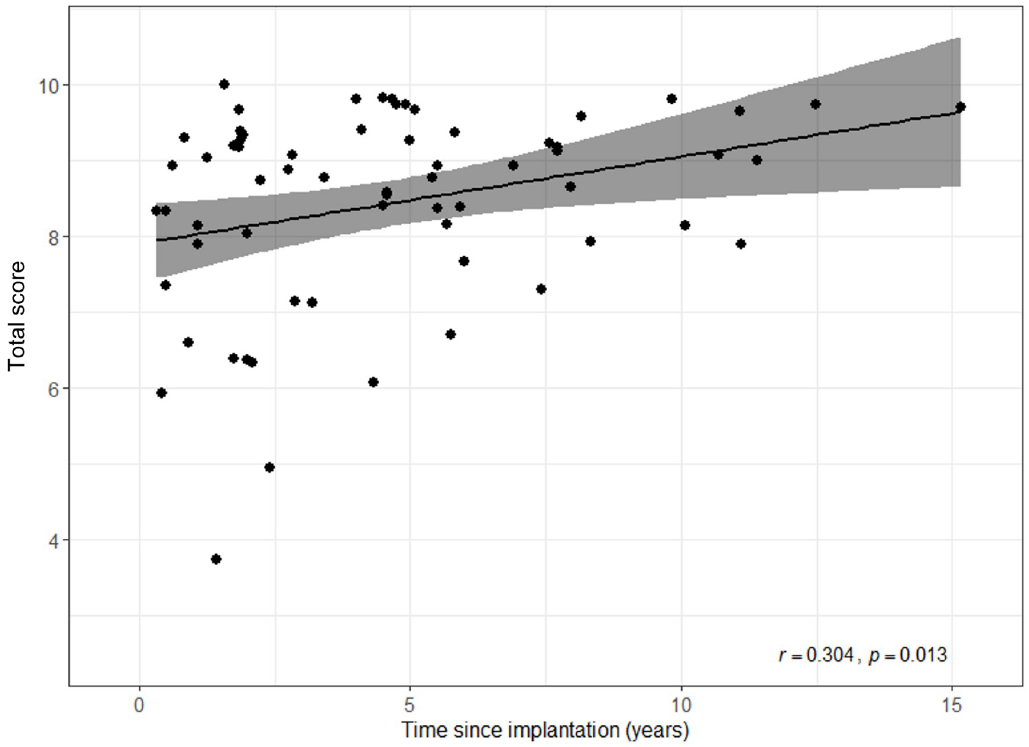
Fig 1. The correlation between time since implantation and the total